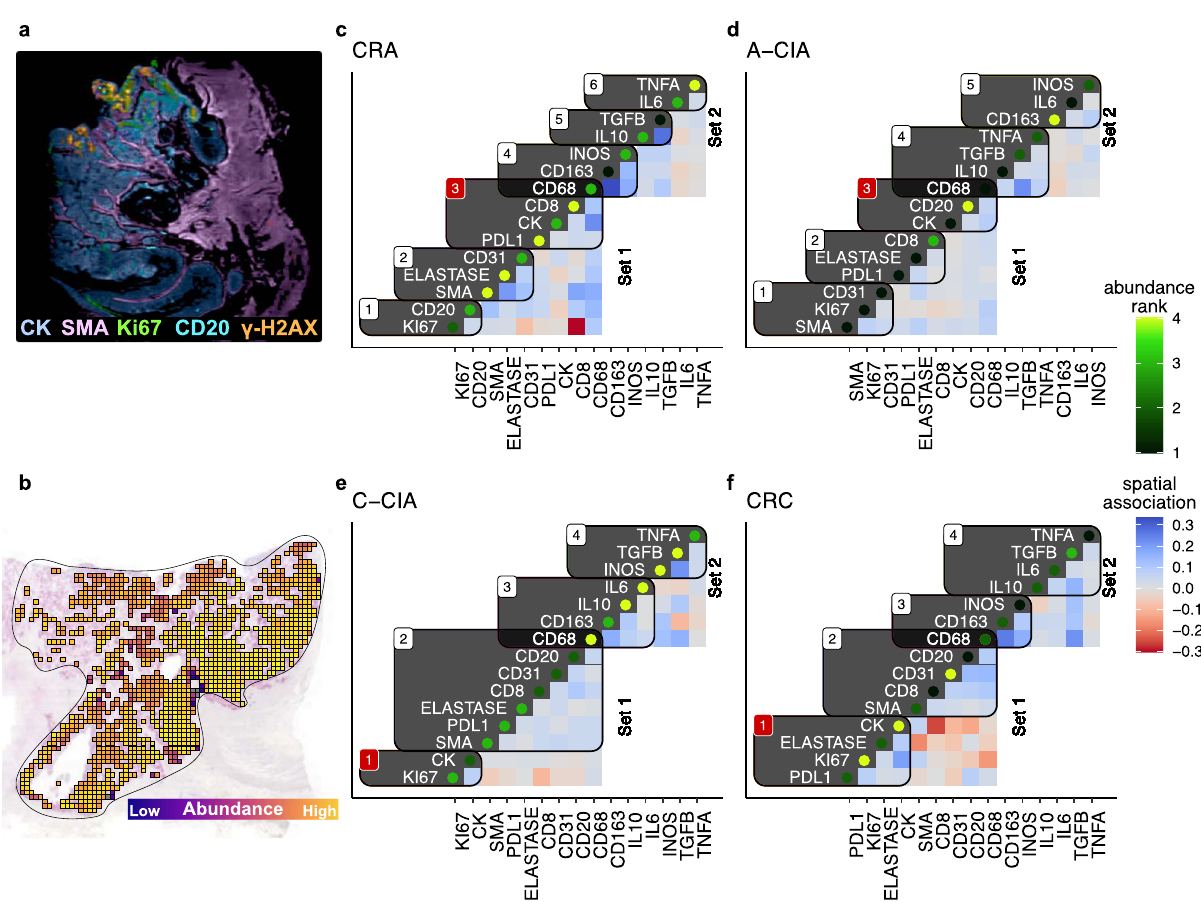
Fig. 7 Changes in direct spatial associations. a Composite images were created by aligning each sample ’ s collection of serial slices. This example shows only fi ve markers, but all markers were used for the spatial analysis. b Each composite image was then divided into quadrats 250 microns in width and height, wherein each marker was quanti fi ed at ×40 magni fi cation. This image shows the quadrat positions overlaid on one image in the aligned series. c – f ) Averaged spatial association networks, clustered by spatial communities (black boxes), with the tumor community labeled in red. The Set 1 samples included n = 10 colorectal adenomas (CRA), n = 16 progressed adenomas (A-CIA), n = 17 early carcinomas (C-CIA), and n = 13 colorectal carcinomas (CRC), while the Set 2 samples included n = 8 CRA, n = 6 A-CIA, n = 9 C-CIA, and n = 7 CRC. The order of cell types within each community does not have meaning. The color of each element in the lower diagonal indicates the average spatial association between the marker pair, with positive blue values indicating clustering, and negative red values meaning cell types/cytokines are found in separated areas. The color of the circle on the diagonal denotes the ranked abundance, e.g., CD8 is highest in CRA (yellow circle) and lowest in CRC (black circle). The interaction networks for both sets have been overlaid on one another using CD68, the only marker found in both datasets (Set 1 and Set 2). Tumor cells in CRA cluster with a mix of pro- and anti-tumor immune cells, suggesting that an anti-tumor immune response is being mounted despite the presence of immune escape mechanisms. In contrast, tumor cells in progressed adenomas (A-CIA) reside in a predominantly immunosuppressive niche, being associated with B cells (which can promote an M2 macrophage phenotype) and macrophages, which are in turn clustered with immunosuppressive cytokines (IL-10, TGF- β